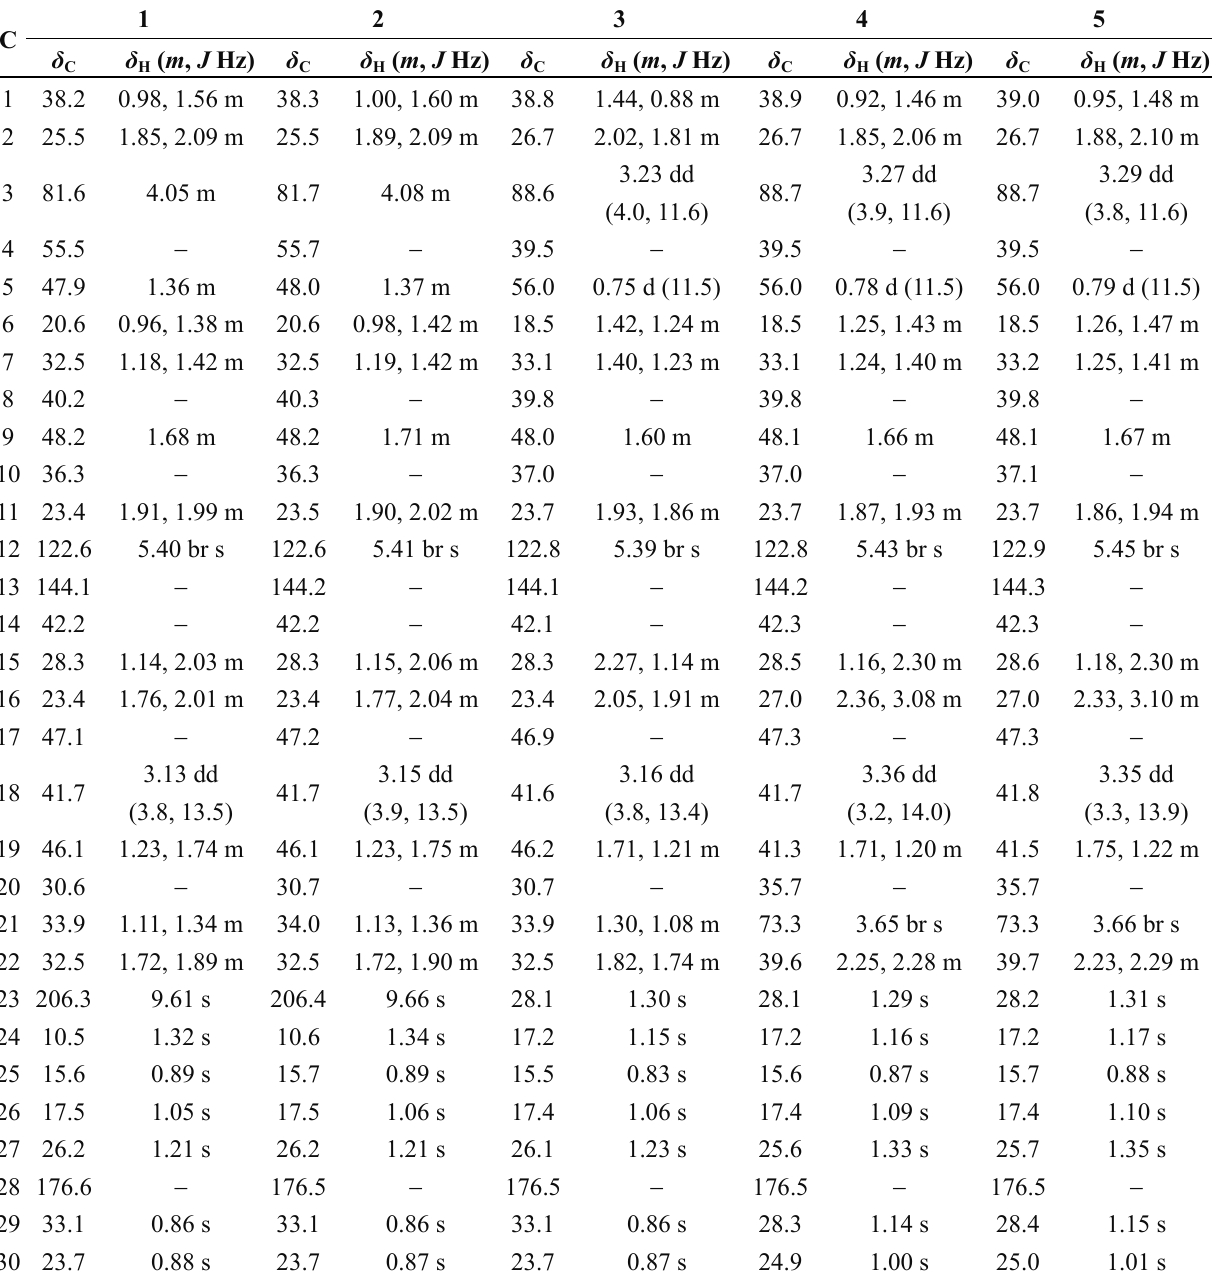
Table 1. 1 H- (500 MHz) and 13 C-NMR (125 MHz) chemical shifts assignments for the aglycone moieties of compounds 1  5 in pyridine- d